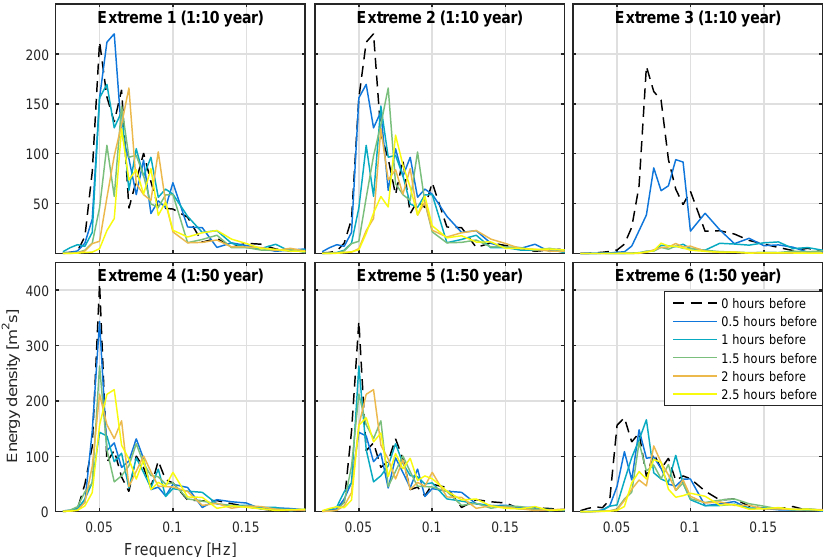
Figure 13. Frequency spectra change for the three hours prior to the extreme sea state identified. 1 ) to 6 ) correspond to sea states 1 to 6 defined in Table